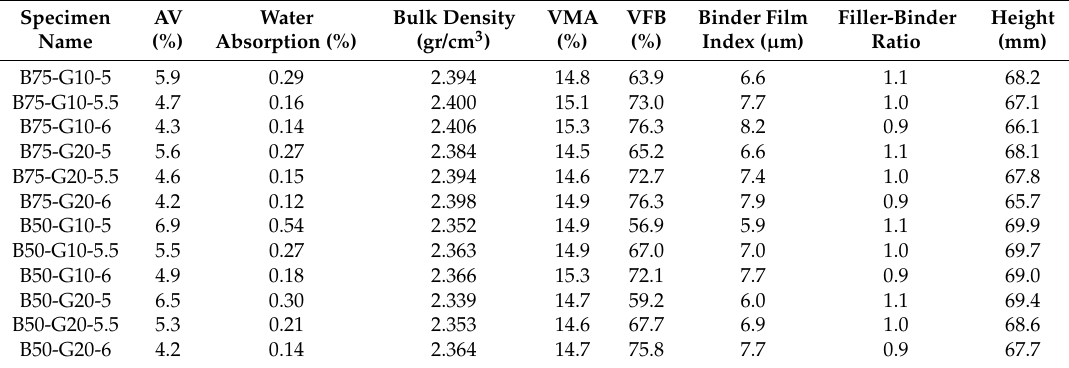
Table 8. Volumetric properties of asphalt mixtures containing RCA and glass.